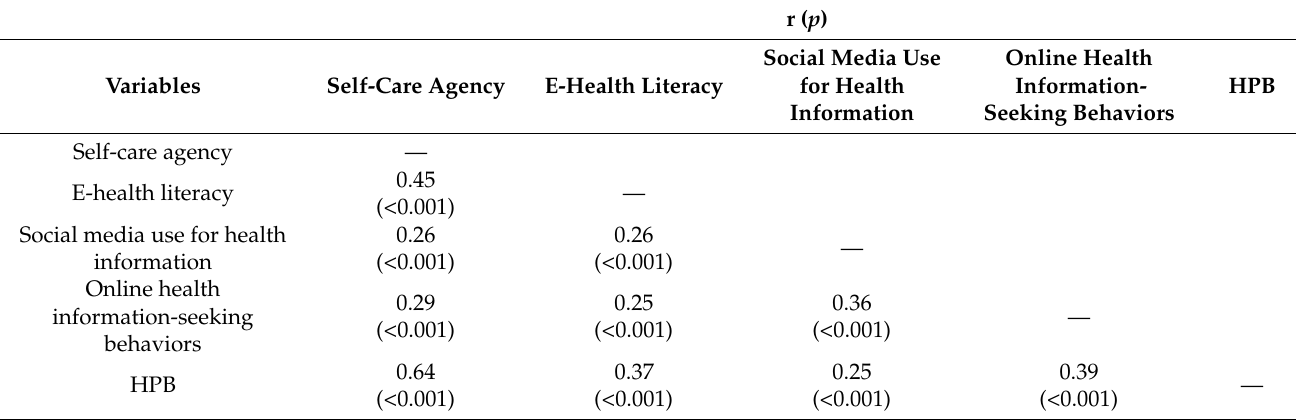
Table 2. Correlations between self-care agency, e-health literacy, social media use for health information, online health information-seeking behaviors, and HPB ( n =